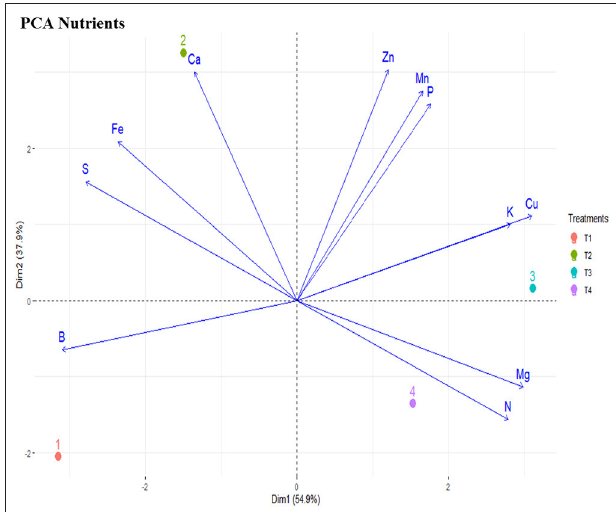
FIGURE 3 | Principal component analysis for nutrients on Tectona grandis seedling at 90 days. T1, Control; T2, PGPR Bacillus subtilis ; T3, AMF Rhizophagus clarus ; T4, PGPR + AMF.